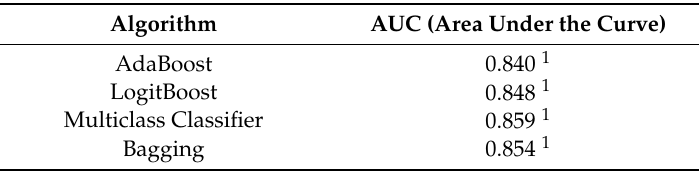
Table 3. The area under the curve (AUC) of each model.